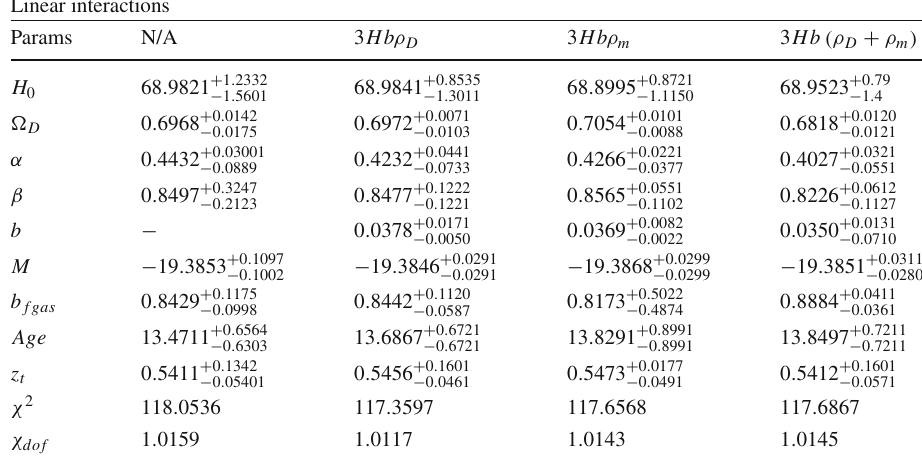
Table 4 The fitted values of cosmological parameters for the extended holographic Ricci dark energy model (Eqs. (21) and (22)) using linear and non-linear interactions listed in Table 1.